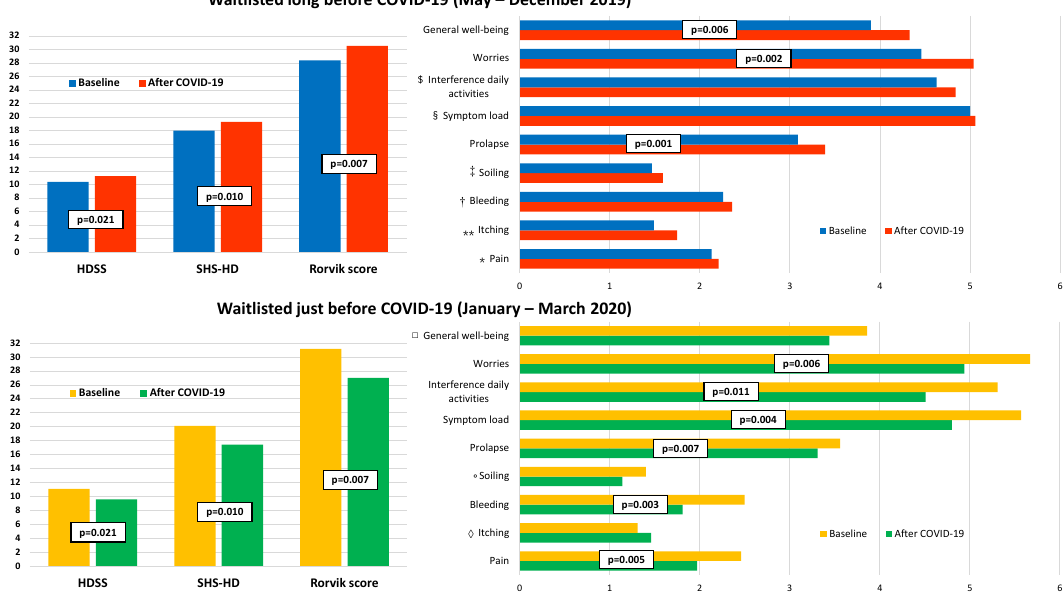
Figure 2. Comparison between Rørvik score in patients waitlisted a long time and just before COVID-19 quarantine. * p = 0.461; ** p = 0.051; † p = 0.298; ‡ p = 0.141; § p = 0.593; $ p = 0.137; ♦ p = 0.272; ◦ p = 0.359; (cid:3) p = 0.172. Table 2. Analysis of factors that influenced Rørvik score changes during COVID-19 quarantine. Baseline vs. After COVID-19 Delta * p Long time (67) ** Time in waiting list before COVID-19